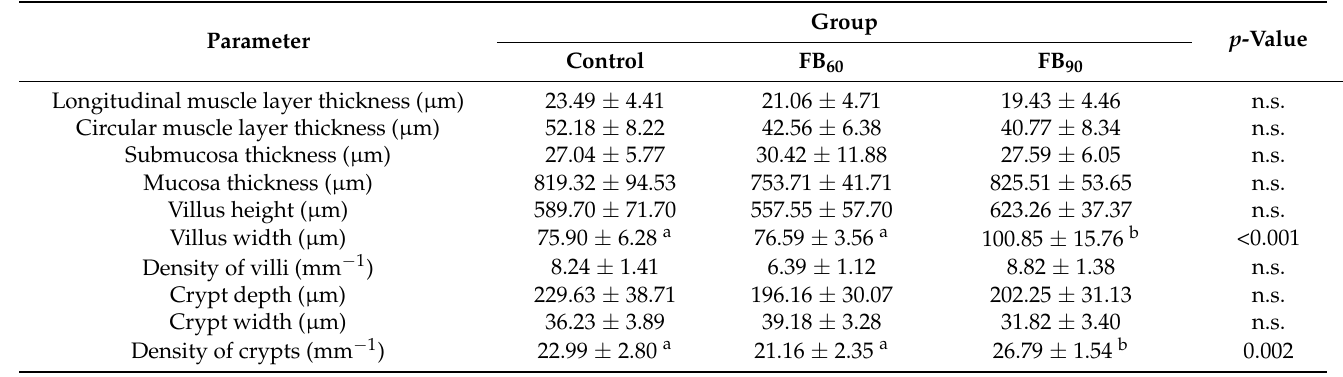
Table 4. Effect of the fumonisin intoxication on the rat duodenum morphology (mean ± SD).